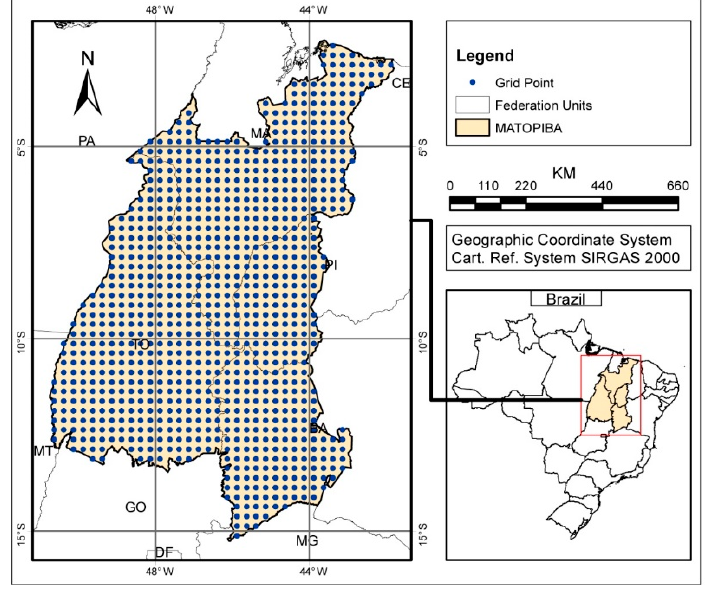
Figure 1. Geographical location of MATOPIBA in relation to Brazil ( lower right map ) and spatial distribution of data points referring to meteorological variables ( left map ).